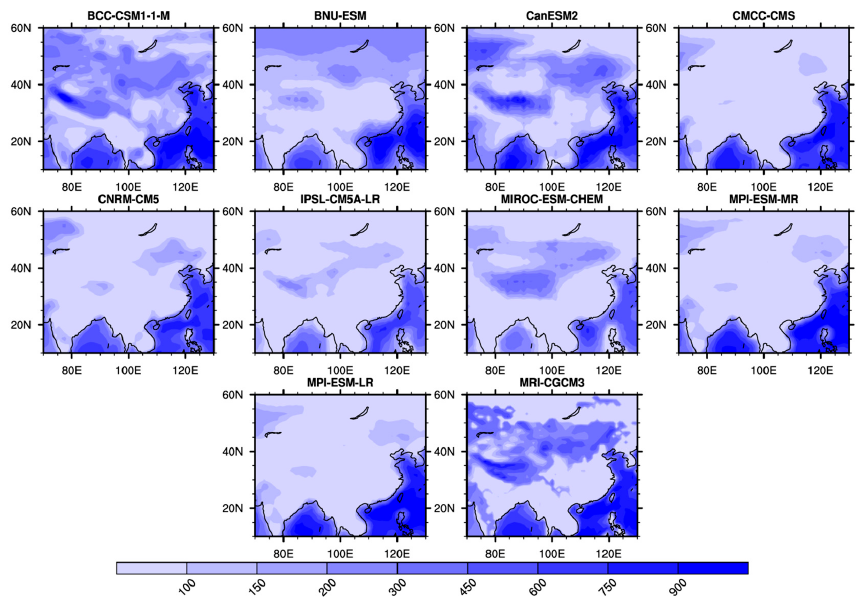
Figure A6. Spatial distribution of projected mean wind power density (WPD) in W / m 2 based on 90 m above ground level extrapolated wind speed for the 2081–2100 for the CMIP5 models under RCP8.5 scenario.